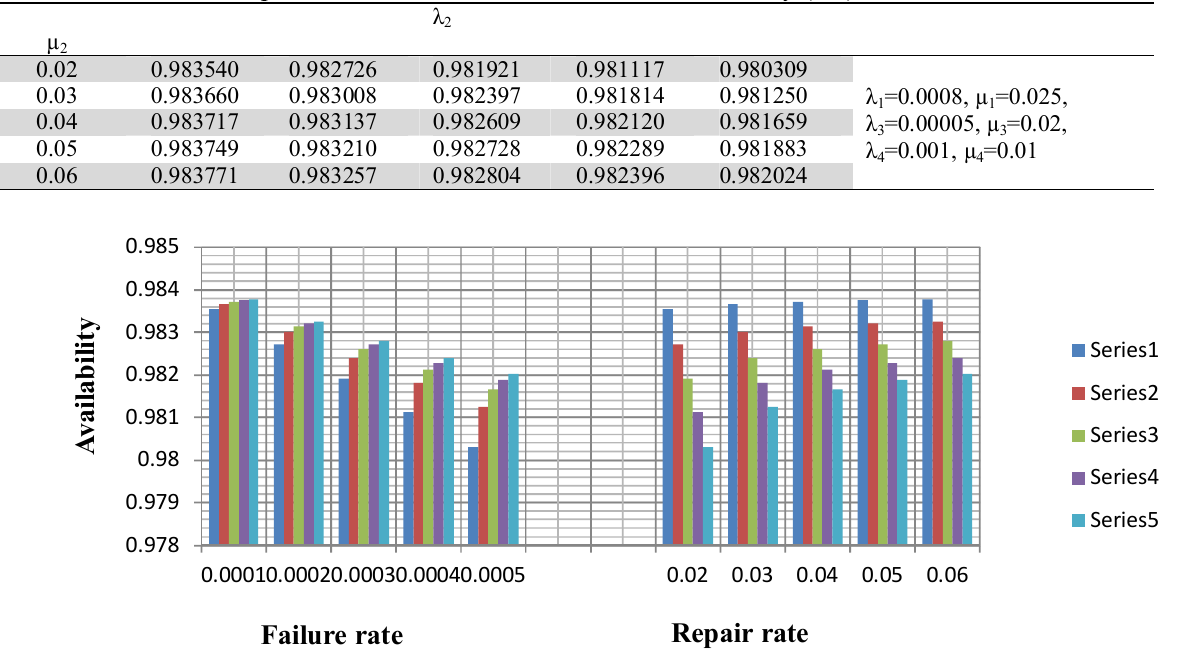
Effect of Failure and Repair Rates of Induced Draft Fan on Availability (A